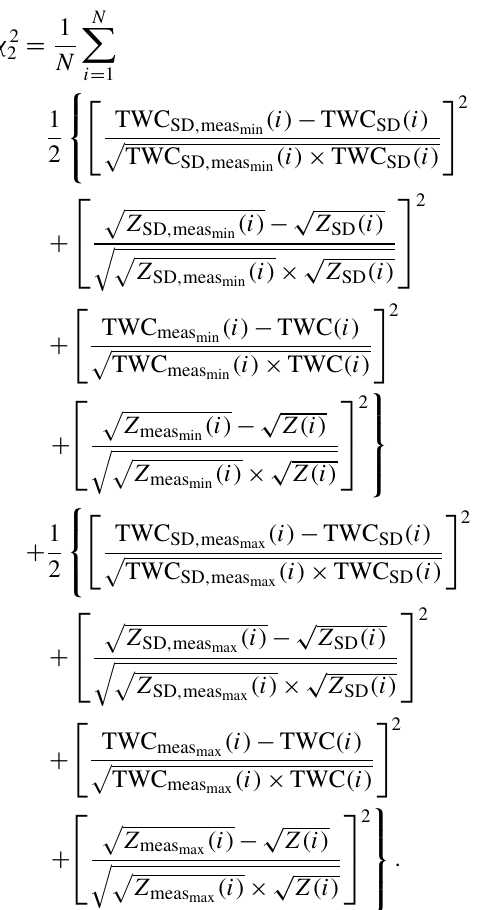
Figure 3. Frequency of χ 2 (red shading), where χ 2 flight leg used in